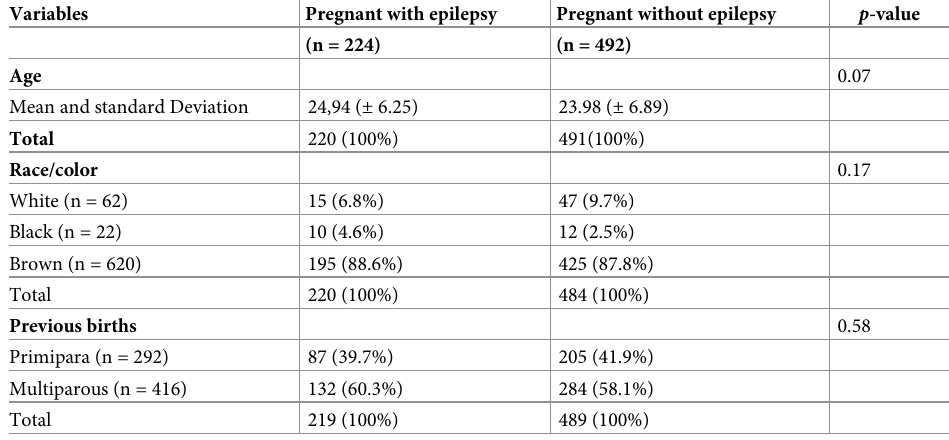
Table 1. Comparison of average socio-demographic and obstetric outcome variables between pregnant women with and without epilepsy.